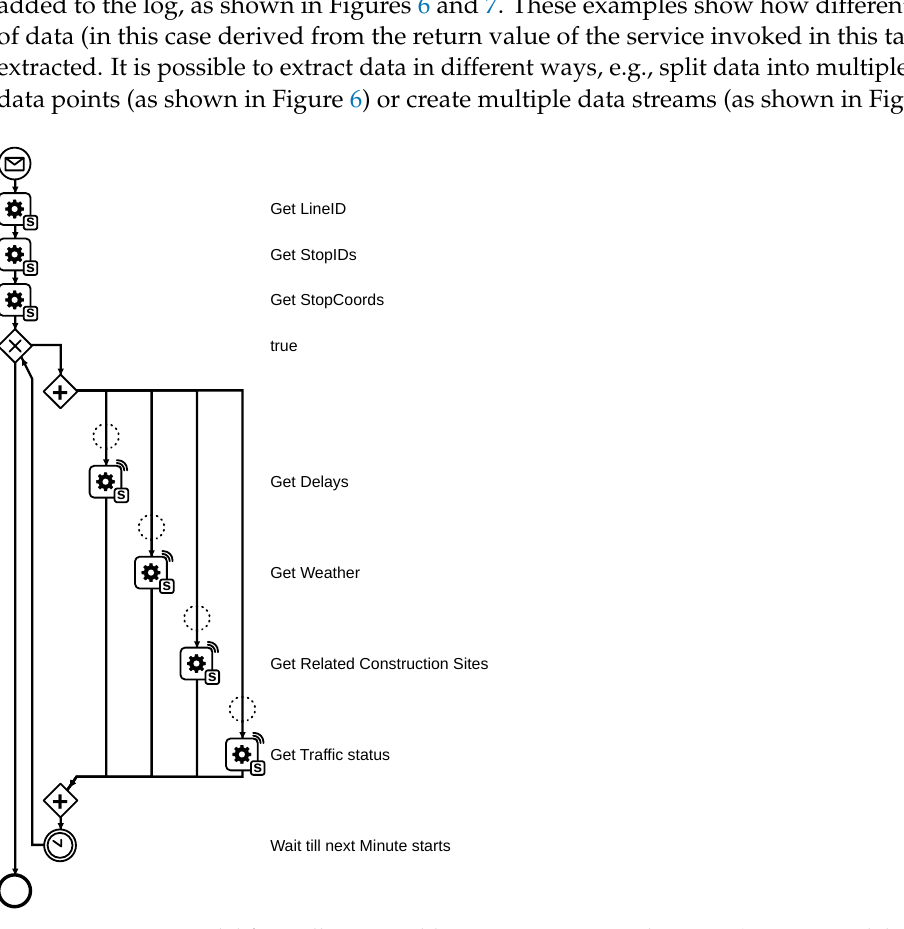
Figure 5. Process Model for Collecting Public Transportation Delay Data (Process model used for creating the dataset described in https://doi.org/10.5281/zenodo.7411234) (accessed on 8 February 2023).